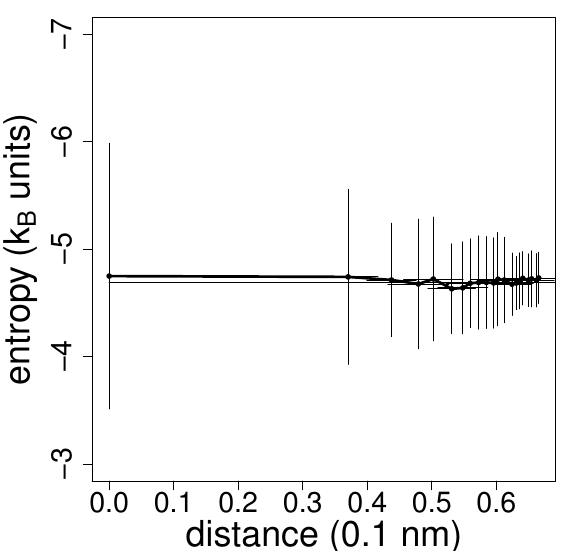
Figure 4. The average estimated entropy (and its extrapolation to zero distance) is plotted against the average distance to the first 20 nearest neighbours with error bars on both distance and entropy estimate. The vertical error bars are equal to the standard deviations of the entropy estimate drawn for each individual molecule in a single snapshot from the first 20 neighbours in all other